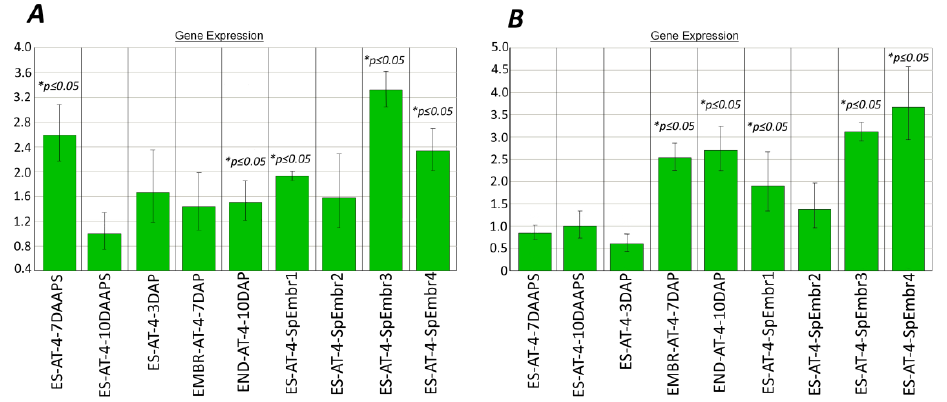
Figure 2. Expression of DNA-methylation genes in the parthenogenic proembryos (10 DAAPS), ESs (7 and 10 DAAPS), and embryos and endosperm (7 and 10 DAP) of the AT-4 line. ( A ) dmt103 ; ( B ) dmt105 . Control: unpollinated ESs (10 DAAPS). * Significant differences between target tissue and control cells (ESs at 10 DAAPS) are expressed as p ≤ 0.05. ES-AT-4-SpEmbr1-4: in one biological experiment, each of the four samples consisted of five ESs with parthenogenic proembryos. Data are presented from two independent biological experiments. ES-AT-4-7-10 DAAPS: in one biological experiment, each sample consisted of 12 unpollinated ESs. Data are presented from two independent biological experiments.